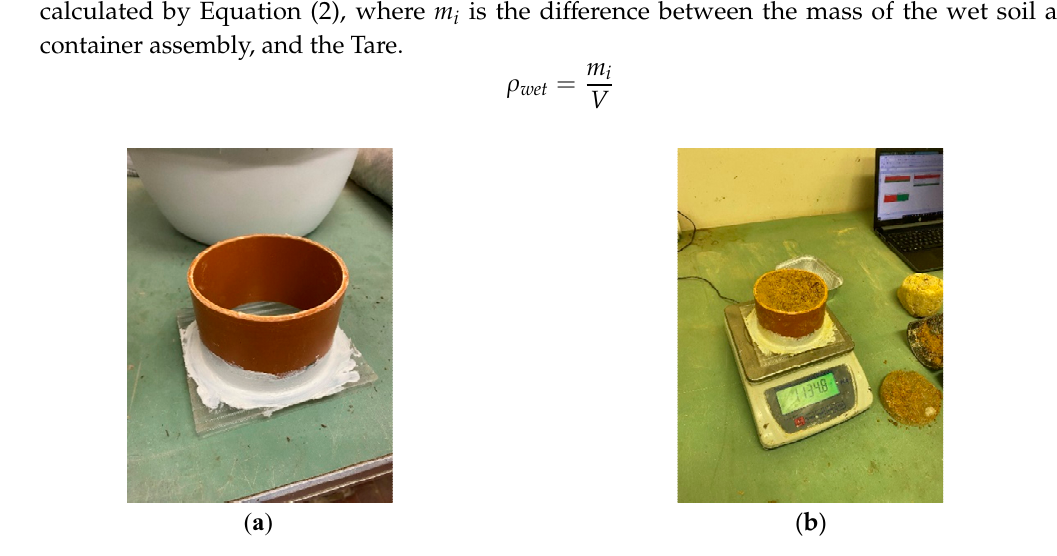
Figure 7. ( a ) Container; ( b ) Weighing of the wet soil sample.